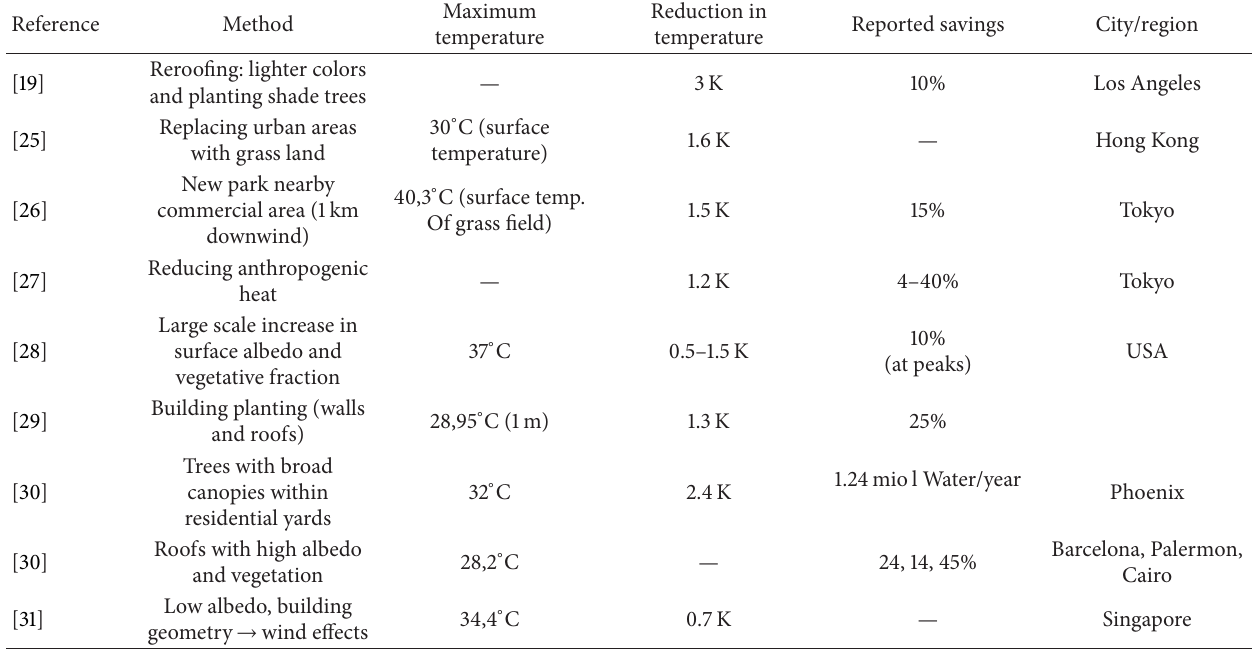
Table 1: A review on maximum temperature in different cities, UHI mitigation methods, and their cooling effects as well as the percentage of energy saving of different UHI mitigation strategies in different regions. Planting shade threes shows the highest cooling effect (3K) in Los Angeles.